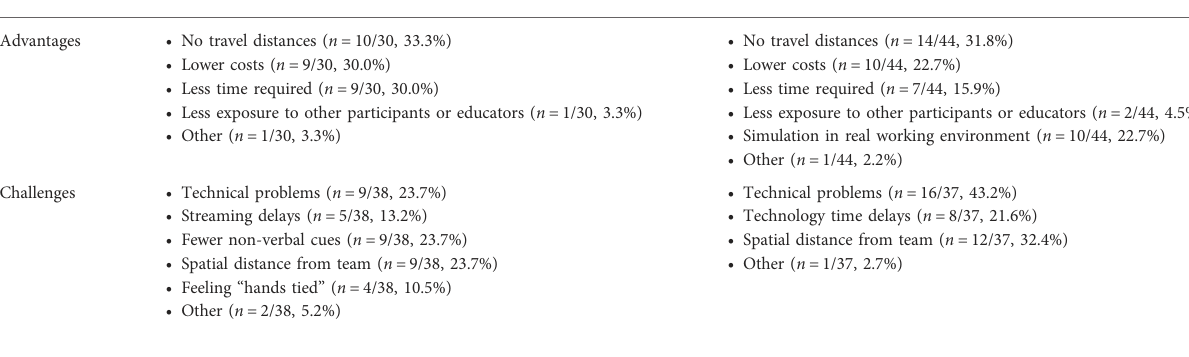
TABLE 4 Reported advantages and challenges with avatar and distance simulation.